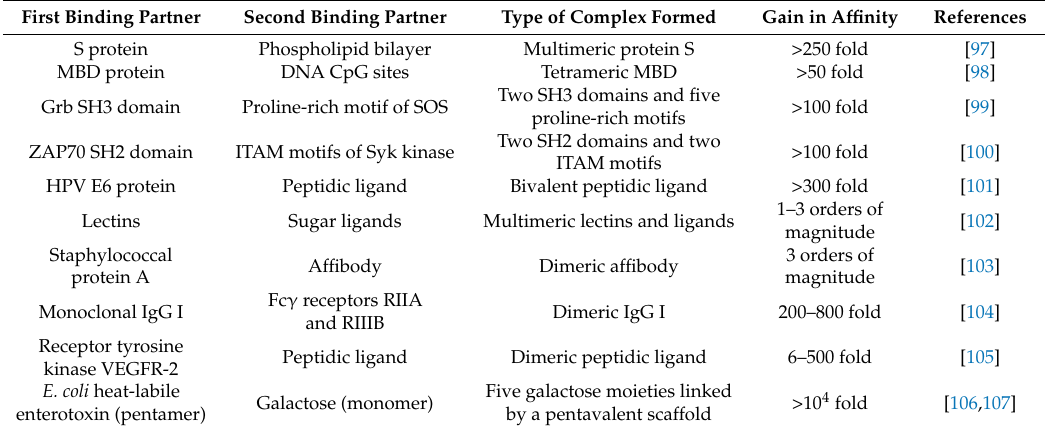
Published examples of increased affinities resulting from multivalent types of protein-ligand